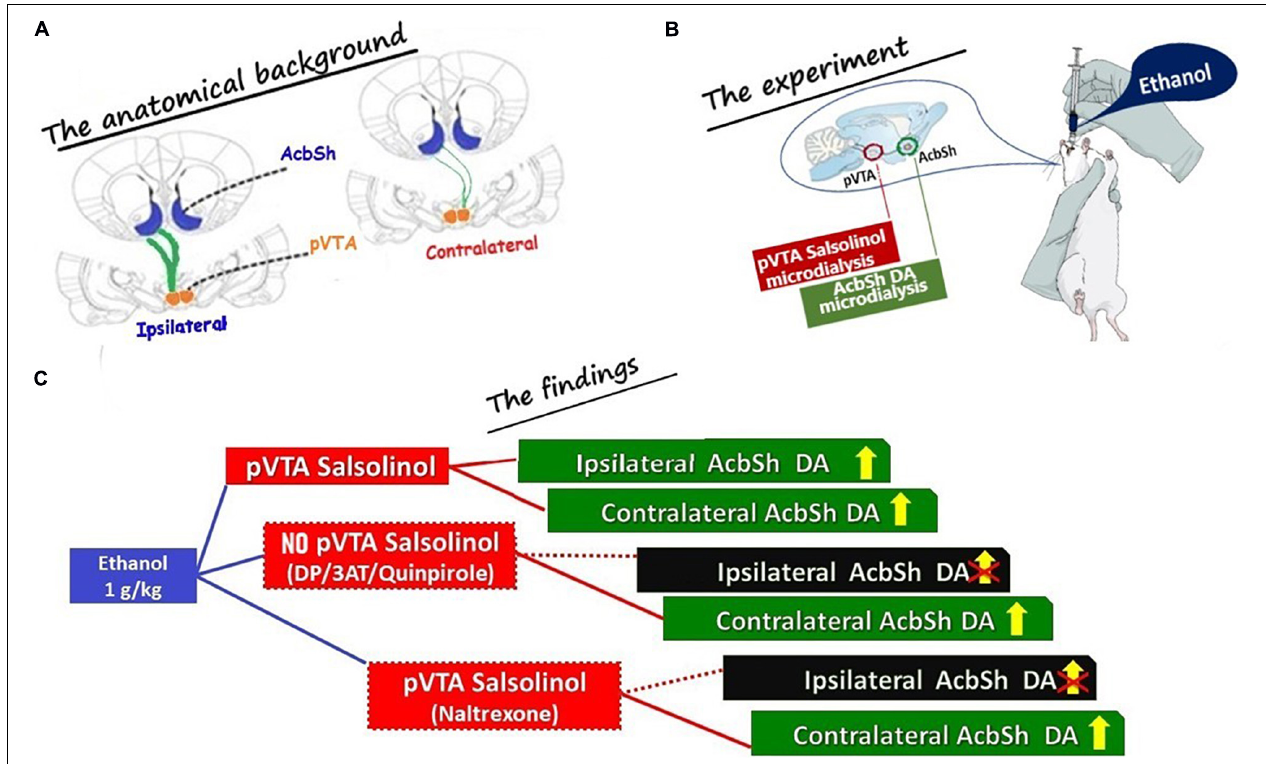
FIGURE 7 | Schematic drawing summarizing (A) the anatomical background exploited during the microdialysis experiments ( The anatomical background ); (B) the main experimental conditions ( The experiment ): (i) ethanol was administered systemically, (ii) salsolinol was sampled from the posterior ventral tegmental area (pVTA), and (iii) DA was sampled from the shell of the nucleus accumbens (AcbSh) of the same (ipsilateral) or of the opposite (contralateral) side with respect to the pVTA; and (C) the main results ( The findings ; shown in Figures 3–6 ). The projections from the pVTA to the AcbSh of the same side (ipsilateral) are shown as thick green lines to indicate that these are prevailing for > 95% (Jaeger et al., 1983; Geisler and Zahm, 2005; Ikemoto, 2007; Breton et al., 2019) on those aiming at the AcbSh of the opposite side (contralateral) shown as green thin lines to indicate that these are only a minority ( < 5%). Dotted red lines are used in (C) to “connect” the box indicating the pVTA where the formation of salsolinol was prevented (DP or 3AT or quinpirole) and indicating the ipsilateral AcbSh where DA release was not stimulated by systemic ethanol. Similarly, a dotted red line is also used in (C) to “connect” the box indicating the pVTA, where there is formation of salsolinol and µ opioid receptors are blocked by naltrexone, and indicating the ipsilateral AcbSh where DA release was not stimulated by systemic ethanol.